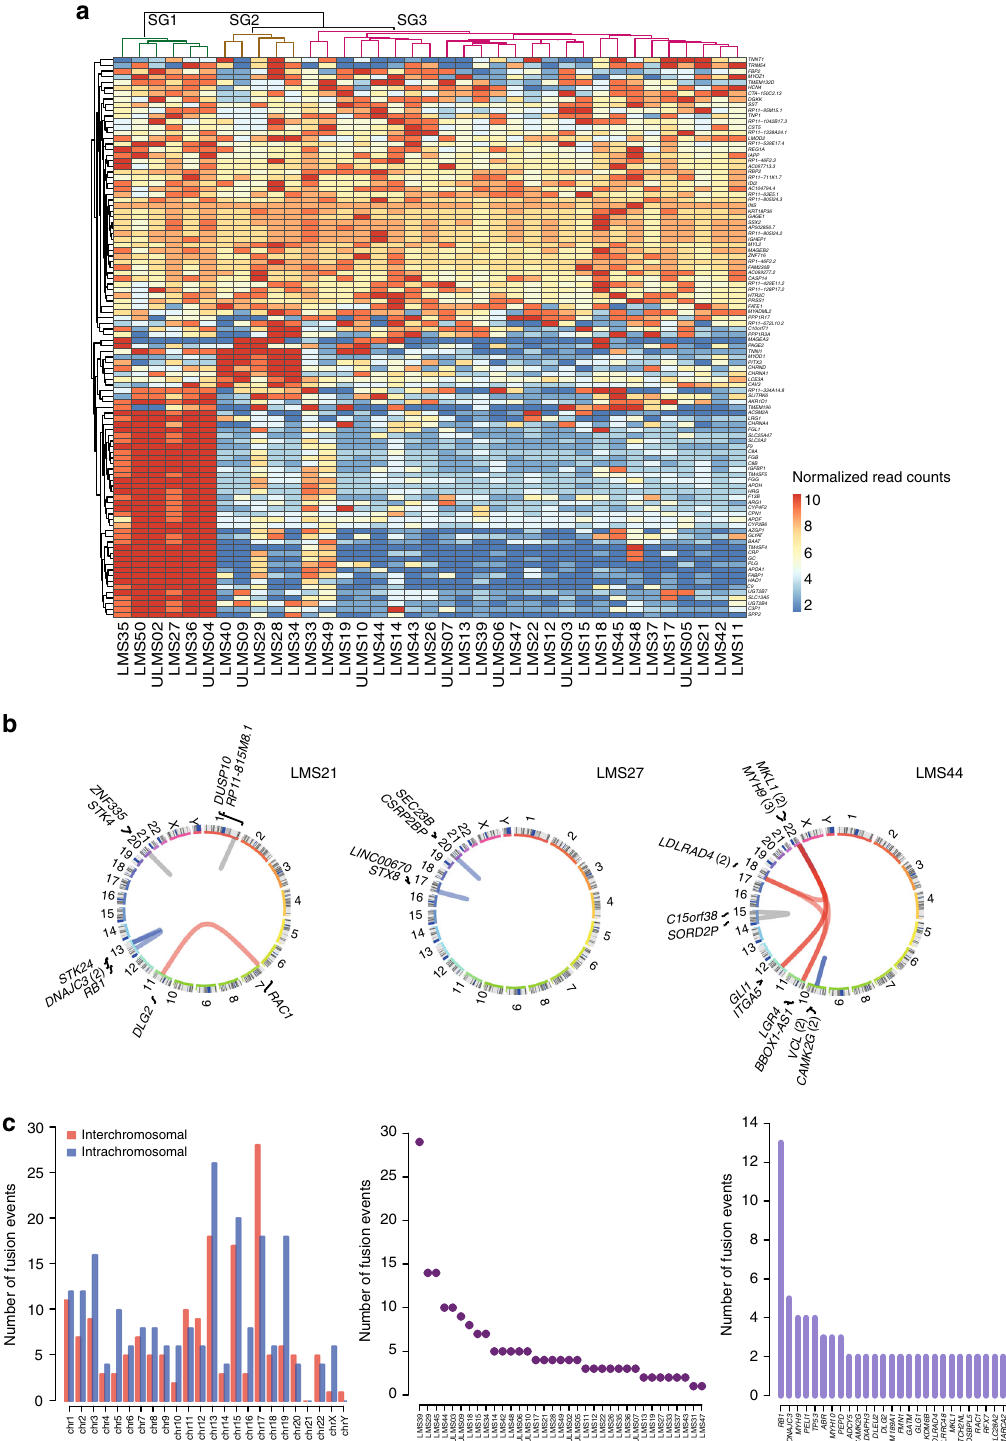
Fig. 3 Transcriptomic characterization of adult LMS. a Unsupervised hierarchical clustering based on the top 100 differentially expressed genes showing separation of tumors into three subgroups (SG1 – 3; dendrogram colors green, brown, and magenta). The heatmap displays normalized read count values for individual genes, which were centered, scaled ( z -score), and quantile-discretized. b Structural variant plots of fusion transcripts in three tumors identi fi ed by TopHat2 and validated by RT-PCR (blue, intrachromosomal; red, interchromosomal) or visual inspection using Integrative Genomics Viewer (gray). Numbers in parentheses indicate the number of fusions involving the respective gene. c Number of fusion events per chromosome (left), tumor (middle), and gene (right). chr,